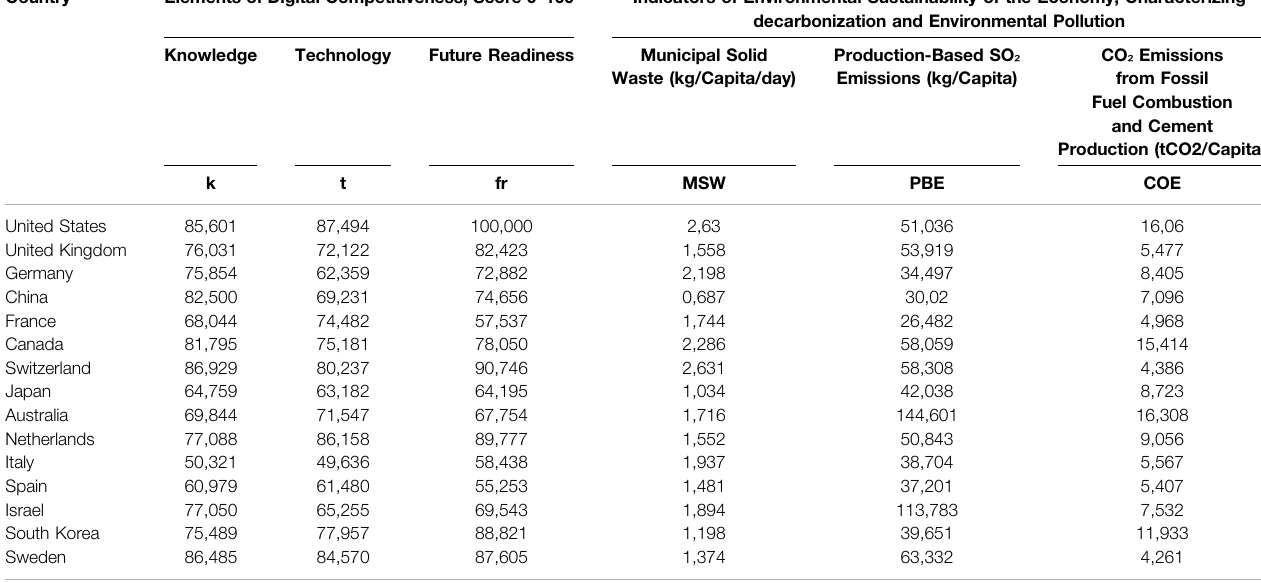
TABLE 1 | Elements of digital competitiveness, greenhouse gas emissions and production and consumption waste in top15 countries/territories in arti fi cial intelligence in 2021. Country Elements of Digital Competitiveness, Score 0 – 100 Indicators of Environmental Sustainability of the Economy, Characterizing